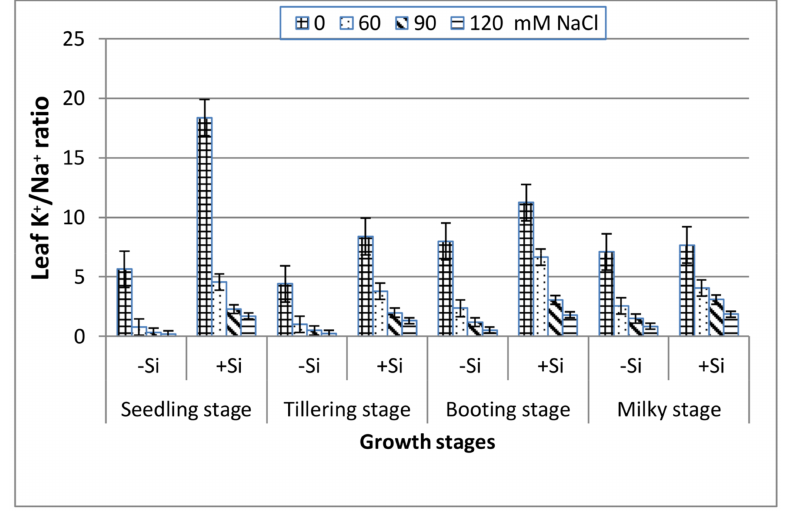
Figure 5. Effect of NaCl on the leaf K + /Na + ratio of wheat at different growth stages in the presence and absence of